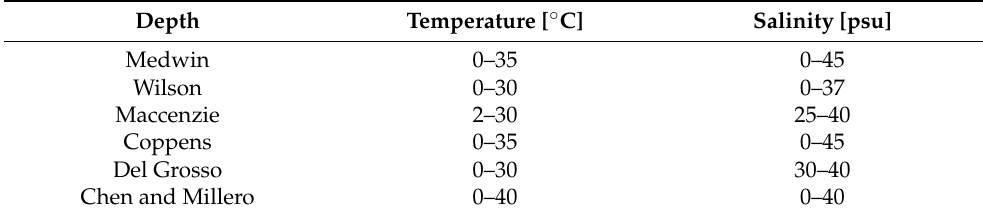
Table 2. Limits of formulas for determination the sound speed in